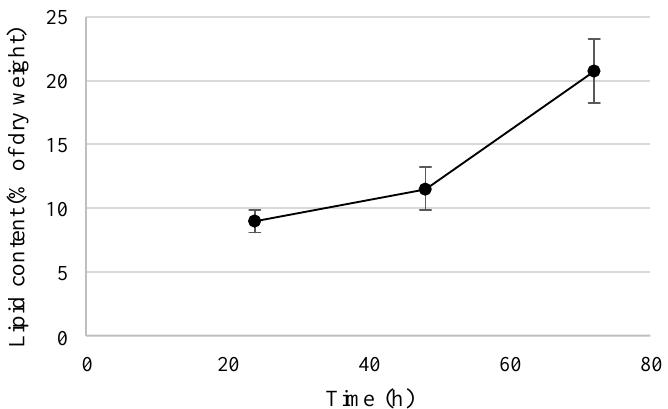
Figure 3. Lipid production by the Mo40 strain cultivated in lipidogenic medium (high C/N ratio). Table 2. Amino acid composition of Mo40 biomass obtained after growth in industrial-like sea- water-based medium containing glucose and xylose (IMSS).